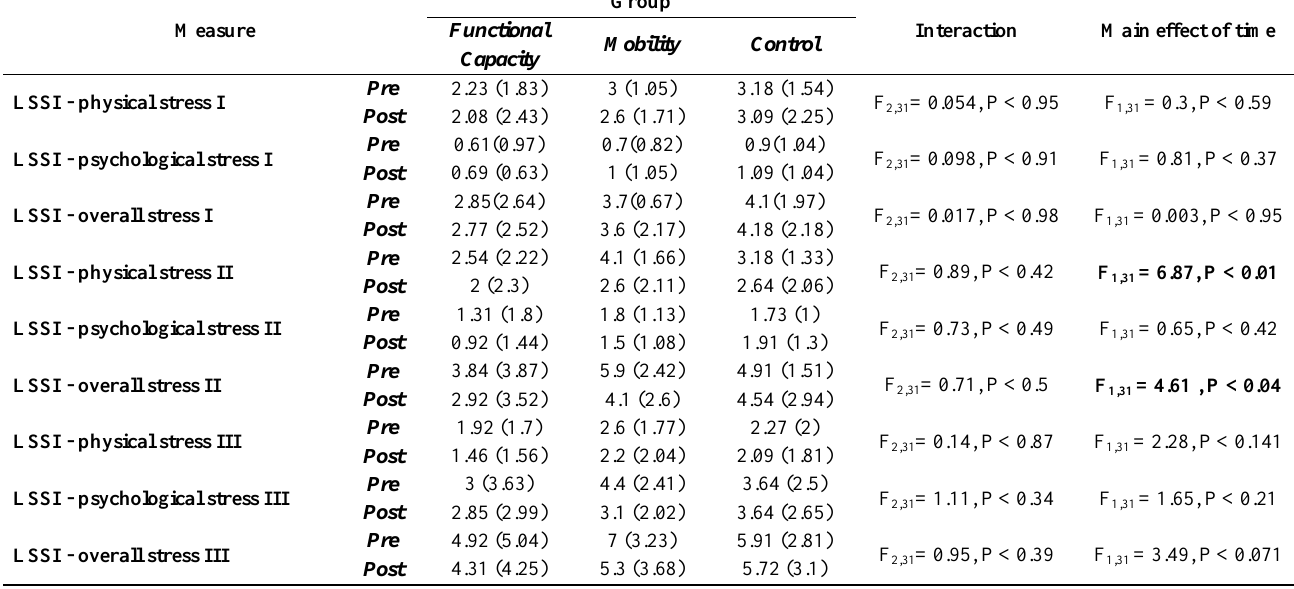
Table 2. Means (standard deviation) of stress dependent variables for each group at before (pre) and after (post) intervention and statistical values.